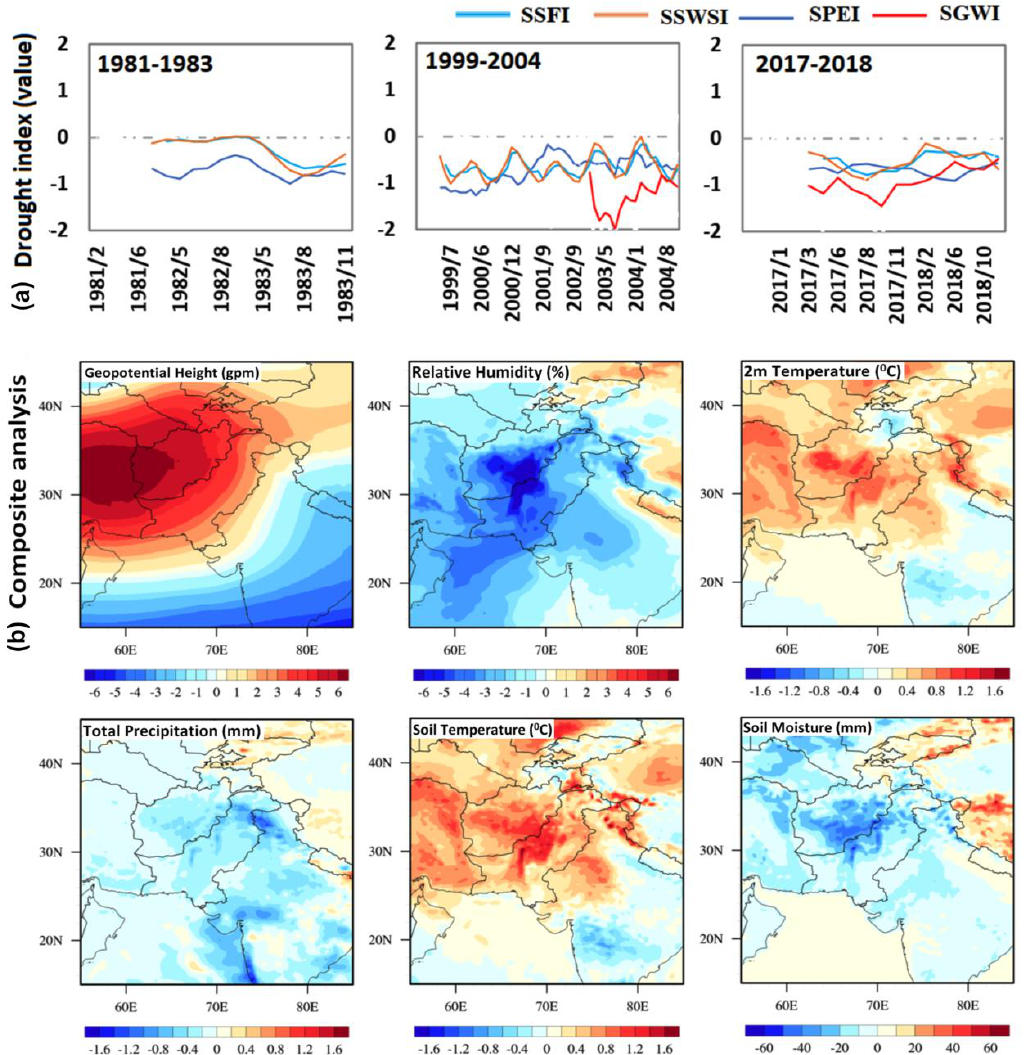
Figure 7. Composite drought years (a) and composite anomalies (b) of the large-scale circulation patterns (i.e., 500 hPa geopotential height, 850 mb relative humidity, 2 m temperature, total precipitation, soil temperature, and soil moisture) during historical (1981 – 1983, 1999 – 2004, 2017 – 2018) drought episodes.